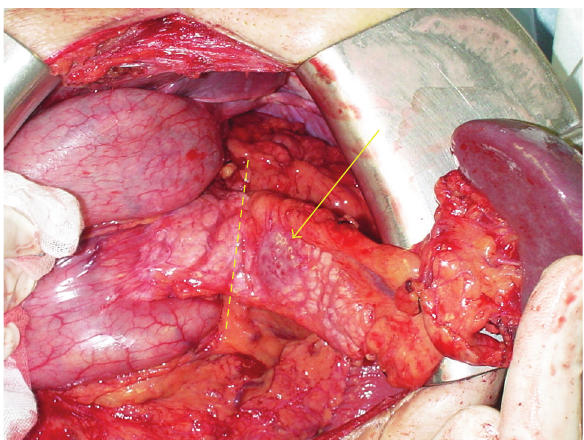
Figure2:Thepancreaswasresectedapproximately2 cmdistaltothe tumor (the arrow indicates the tumor and the dashed line indicates the resection line of the